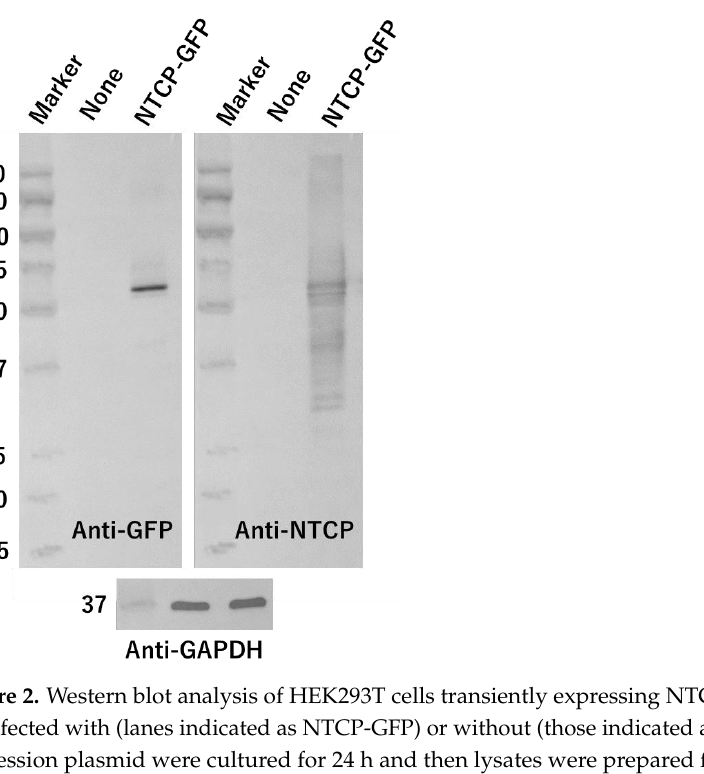
(Figure 2). The molecular weight of the NTCP-GFP fusion protein deduced from the amino acid sequence was about 65 kD. A major band was detected at the position of about 60–70 kD by both anti-GFP and anti-NTCP antibodies. These results indicated that intact NTCP-GFP protein was produced in HEK293T cells transfected with the expression plasmid. The schema of an experimental procedure to demonstrate liposomal binding to NTCP-GFP expressed on HEK293T cells via Myr47-Bio+SA is shown in Figure 3. We treated these cells with Myr47-Bio+SA and then washed off excess Myr47-Bio+SA. Subsequently, we examined the binding of DiD-liposomes containing biotinylated phospholipids, i.e., DiD-DOPC/PEG-Bio (10%), to Myr47-Bio+SA.